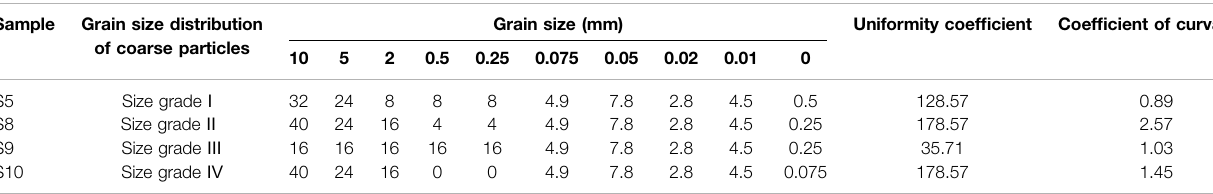
TABLE 2 | Mass percentage of the certain-size grains. Sample